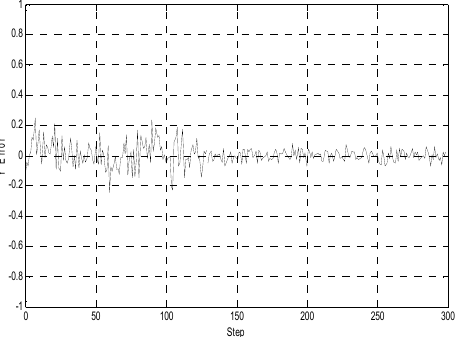
considering the communication delays, the next 200 steps using the proposed method).